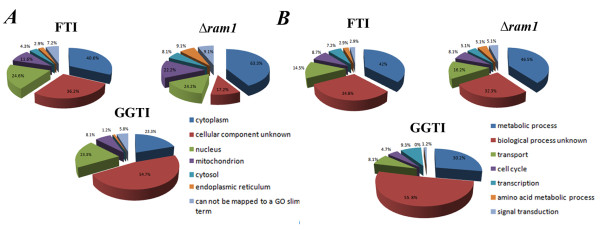
Comparative gene ontology analysis. Pie representation of up-regulated genes using the gene ontology GO-Slim tool at the Saccharomyces Gene Ontology Data base binned for (A) compartment of action and (B) biological processes. FTI, BY4741 cells treated with 10 μM FTase inhibitor I; GGTI, BY4741 cells treated with 10 μM GGTI298; Δram1, untreated YDL090C cells compared to untreated BY4741 cells.